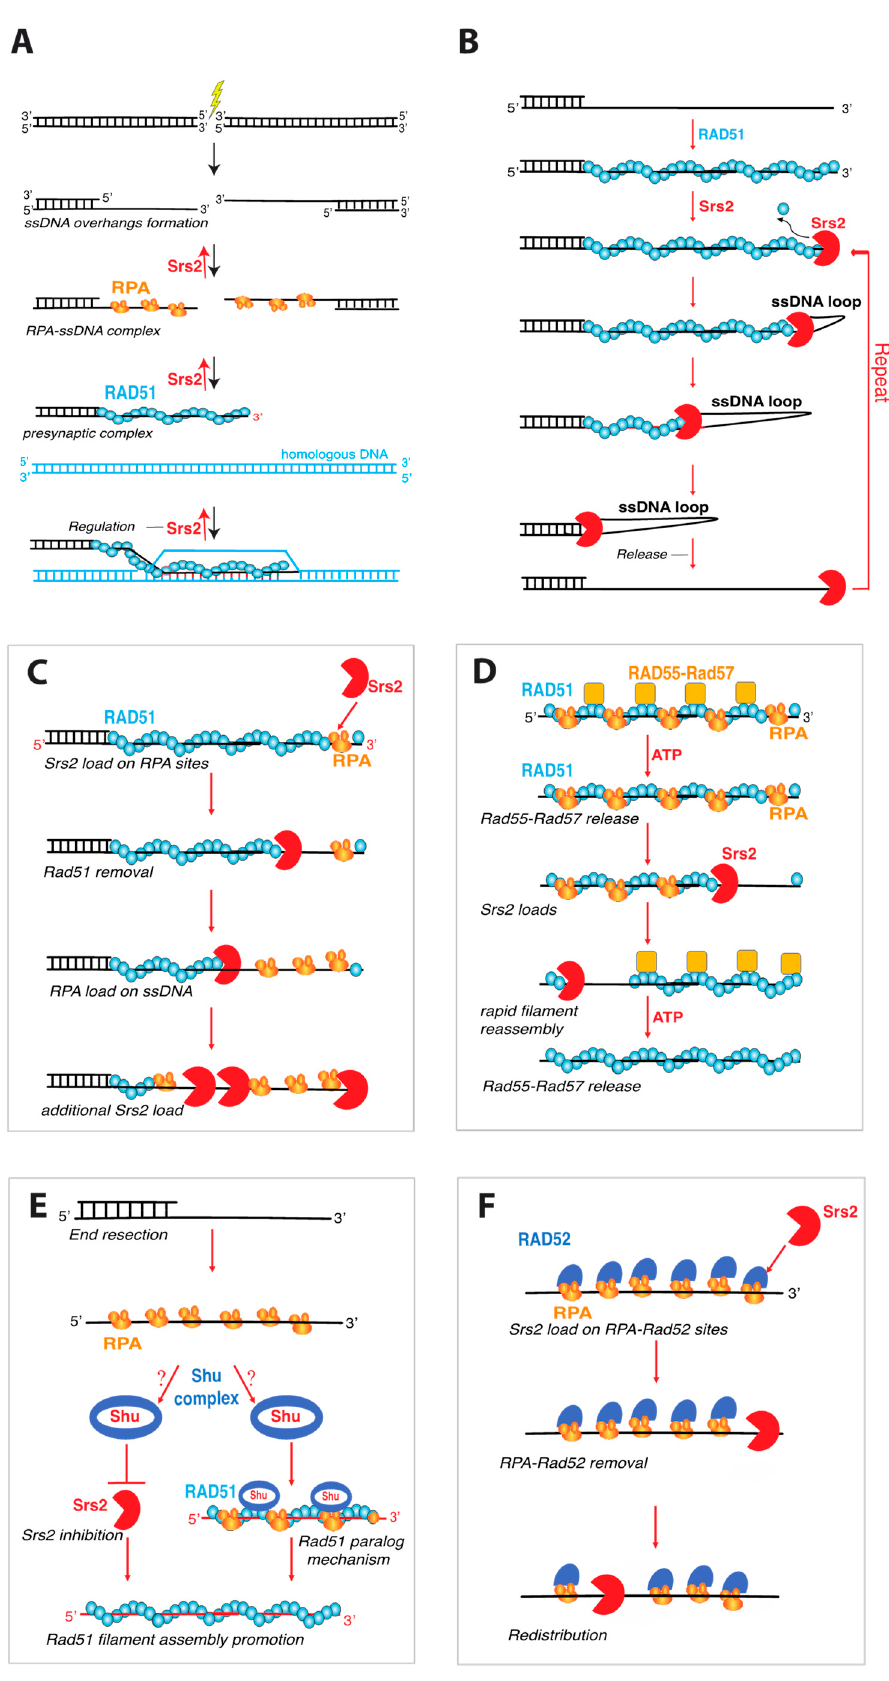
Figure 4. Srs2 antirecombinase activities during Homologous Recombination. ( A ) Schematics of Homologous Recombination (HR). Here, we present an overview of the HR mechanism and